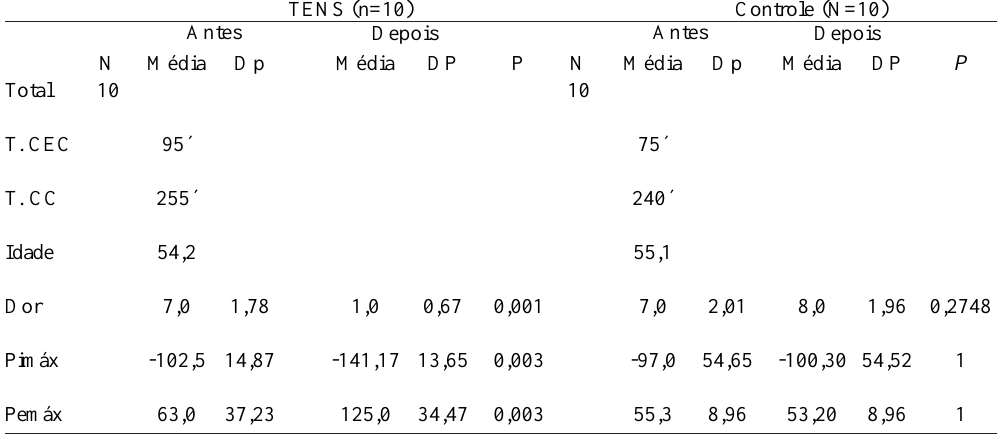
protocolo de pesquisa foi aprovado pelo Comitê de Ética e Pesquisa da FCBS (CEP- FCBS/CESMAC), protocolo